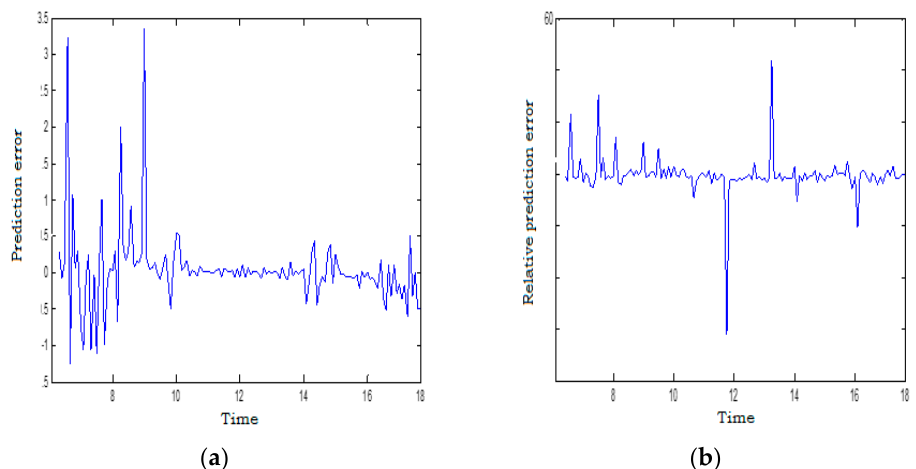
Figure 7. ( a ) Error and ( b ) relative error of the prediction of solar radiation using ARMA (3,3) (for winter day). Table 3. MSE, MAE, and RMSE for the prediction of solar radiation (winter day).